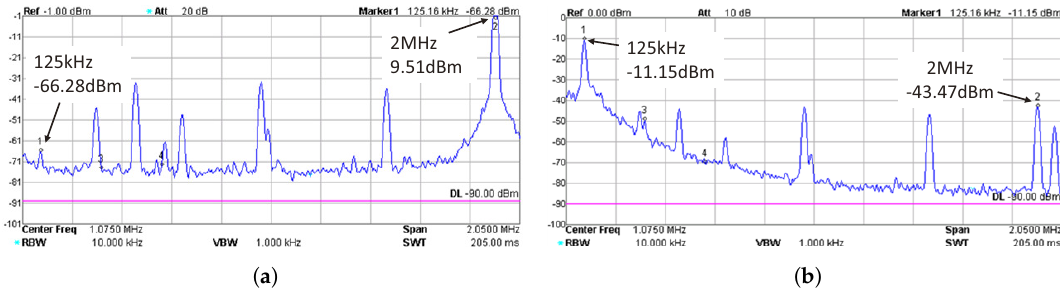
Figure 12. ( a ) The spectrum of the uplink received signal before the uplink receiving filter; and ( b ) the spectrum of the uplink received signal after the uplink receiving filter.